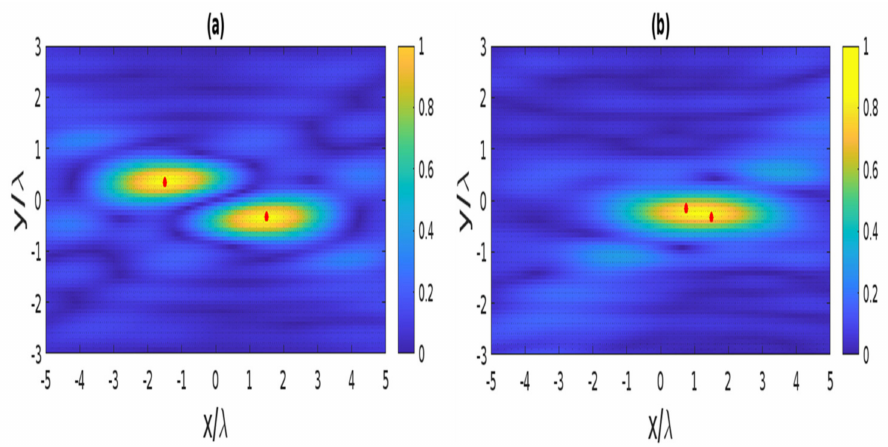
Figure 10. The reconstructed image of two point-like scatterers in the receiving mode when their spac- ing equals ( a ) and is less ( b ) the resolution. The red dots indicate the position of the scatterer points. The reconstruction of four scatterer points in the angle mode is considered in the second example. Now, the resolution is the same for horizontal and vertical lines, i.e.,